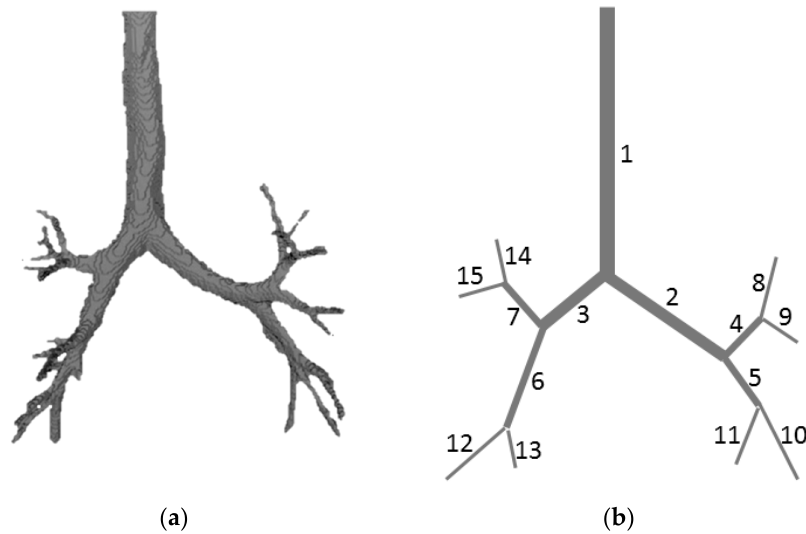
Figure 1. ( a ) 3D segmentation of the individual computed tomography (CT) data of the tracheobronchial tree; ( b ) 1D structure based on the 3D segmentation.